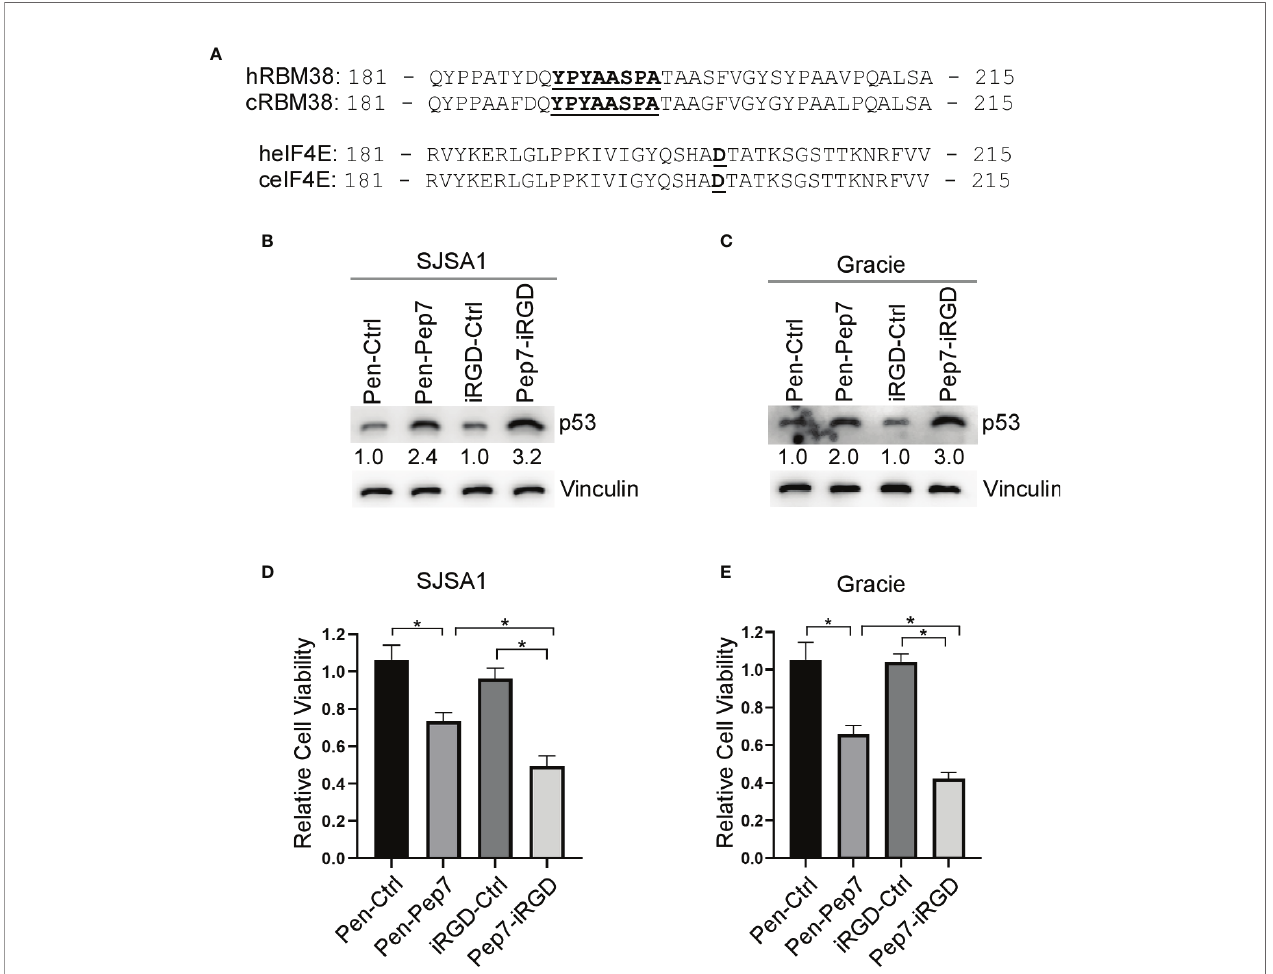
FIGURE 5 | Pep7 enhances p53 and tumor growth suppression in human and canine OSA cells. (A) Comparison of human and canine RBM38 and eIF4E protein sequences focused around their respective binding interfaces. (B, C) The levels of p53 and vinculin were measured in human OSA (SJSA1) and canine OSA (Gracie) cell lines treated with Penetratin or iRGD delivered peptides (20 µM) for 18 hrs. (D, E) Relative cell viability was measured in SJSA1 and Gracie 2-D cell cultures treated with indicated peptides for 24 hrs. Values represent the mean ± SEM of three independent experiments (*, P <